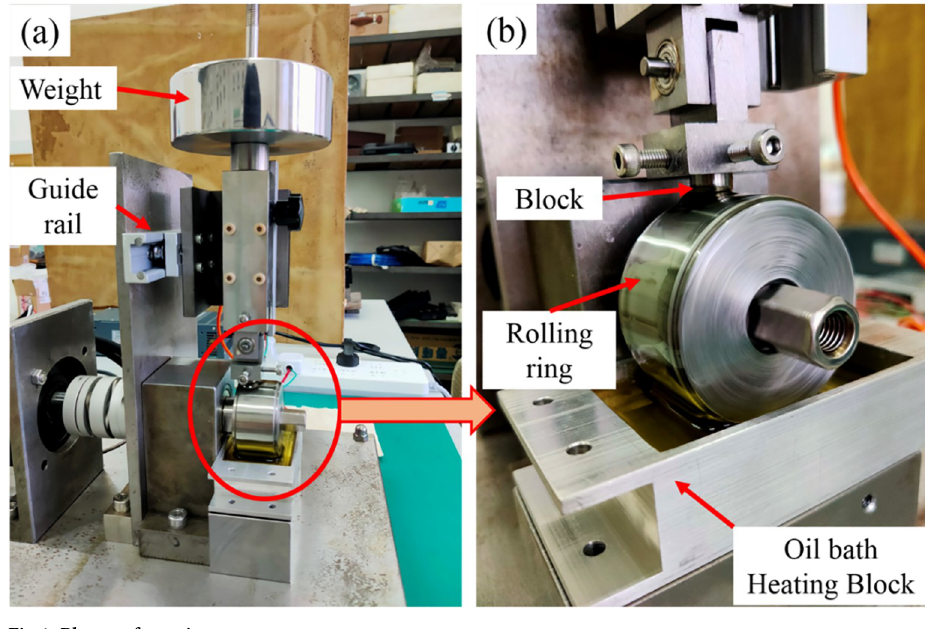
Fig 4. Photos of test rig.